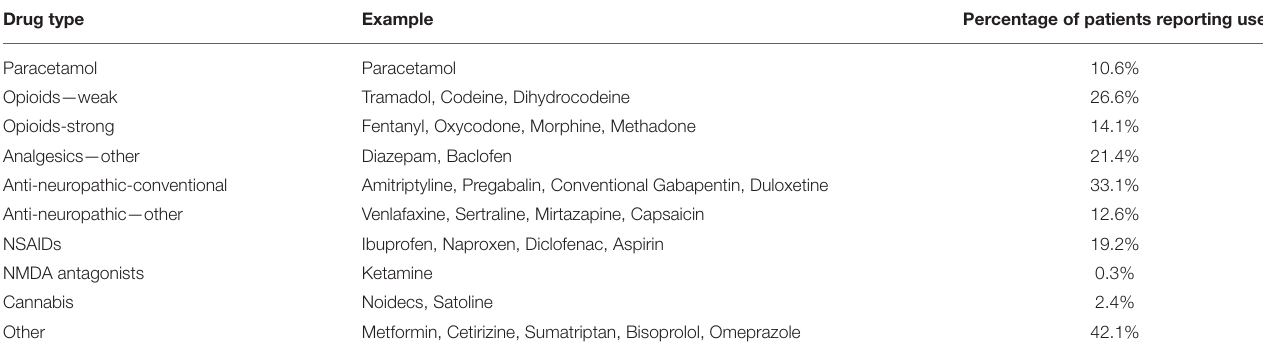
TABLE 5 | Percentage of chronic pain patients using different types of prescribed medications ( N =